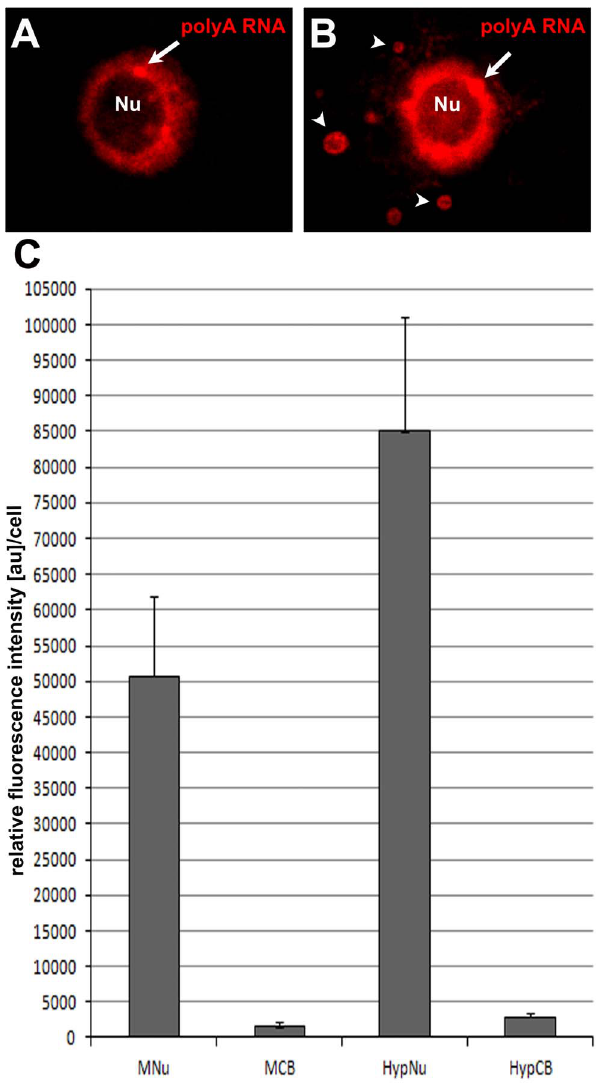
Figure 6. Localisation of poly(A) RNA in control lupine root cells (A) and after submersion to tap water for 3 h (B). Arrows indicate CBs, and arrow heads indicate cytoplasmic granules. Bar, 5 m m. Nu- nucleolus. Quantitative analysis of the fluorescence intensity associated with the localisation of poly(A) RNA. Significant differences in the signal intensity in the nuclei and CBs between control and hypoxia-treated cells (C) MNu- control nucleus, MCB control Cajal bodies, HypNu and HypCB- nucleus and Cajal bodies after hypoxia treatment, respectively (p=0.05). doi:10.1371/journal.pone.0111780.g006 correlated (R . 0,72), weakly correlated (0,72 . R . 0,58) and non-correlated (R , 0,58) distributions are shown in Figure 5K. Indeed, , 60% of CBs strongly or weakly colocalised with BrU- containing RNA after a longer treatment time with the analogue (Figure 5L).